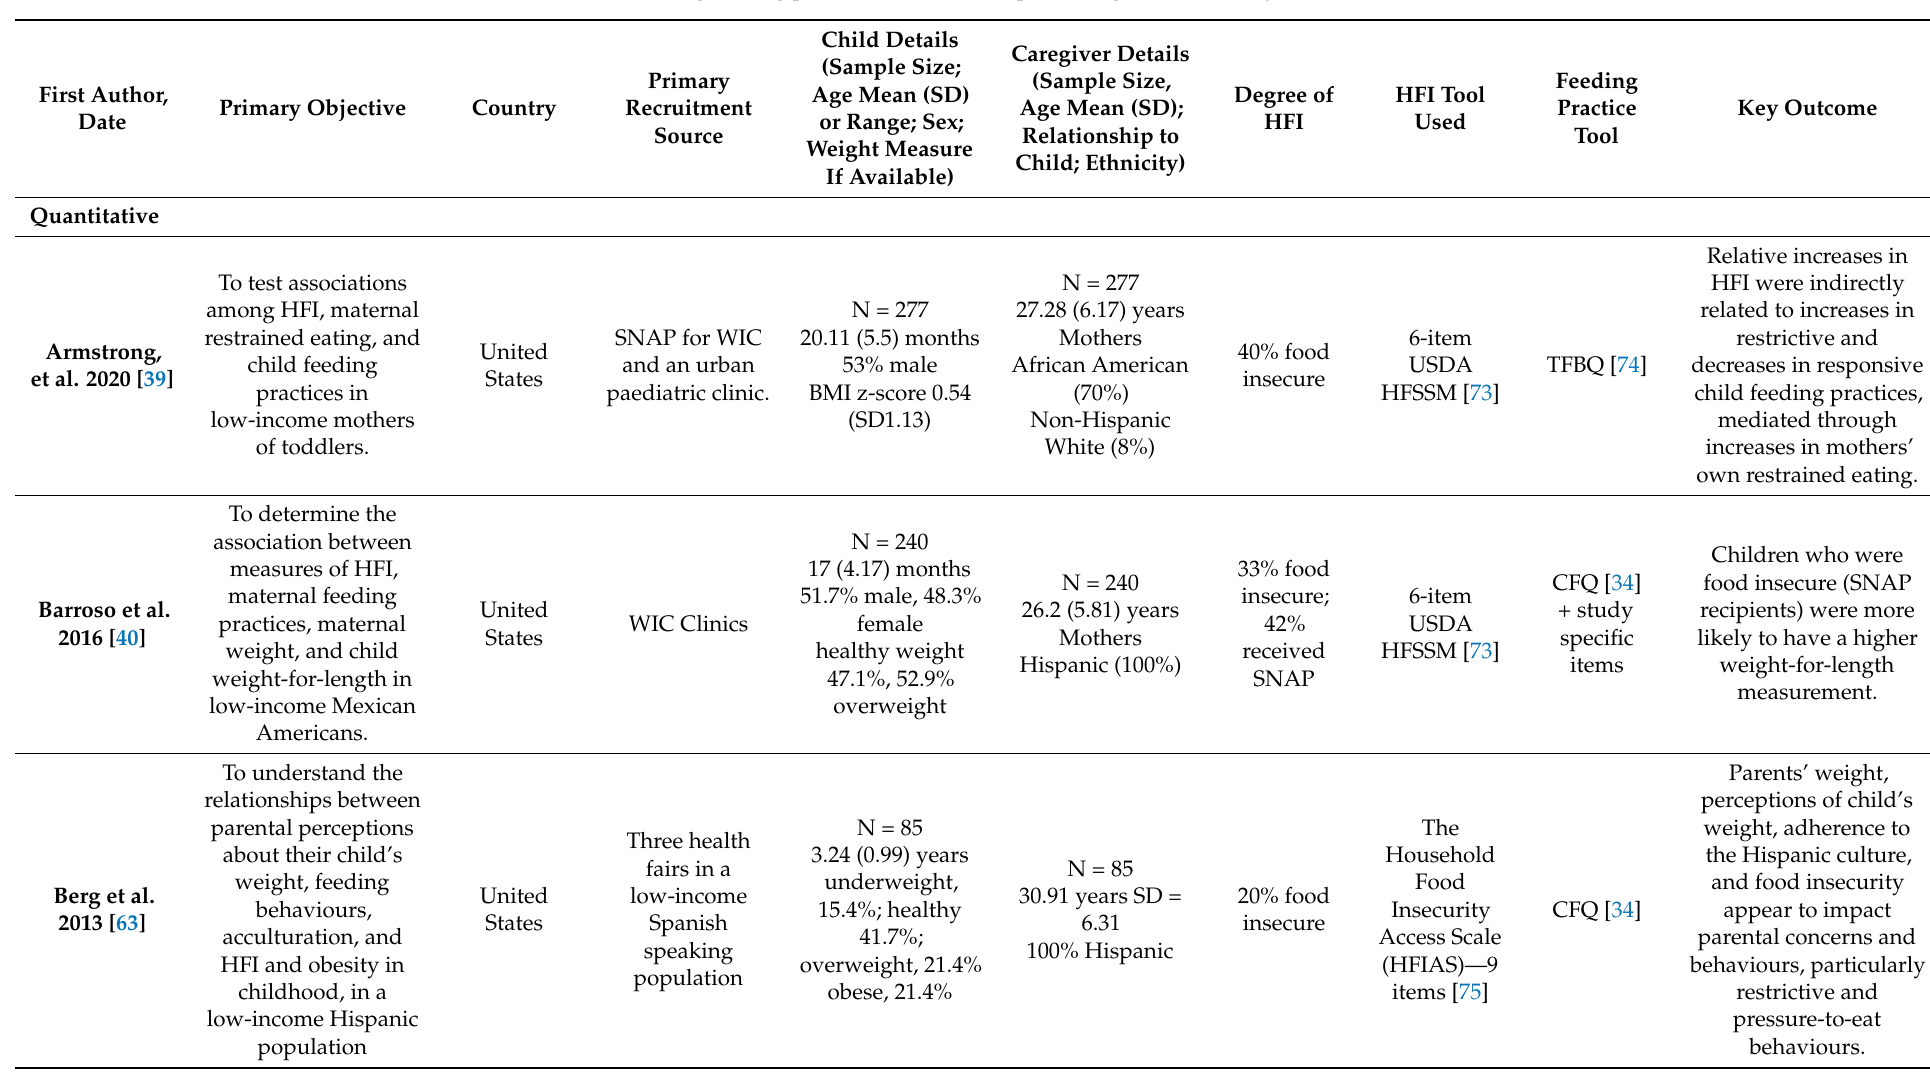
Table 2. Details of studies examining feeding practices in families experiencing food insecurity ( n =